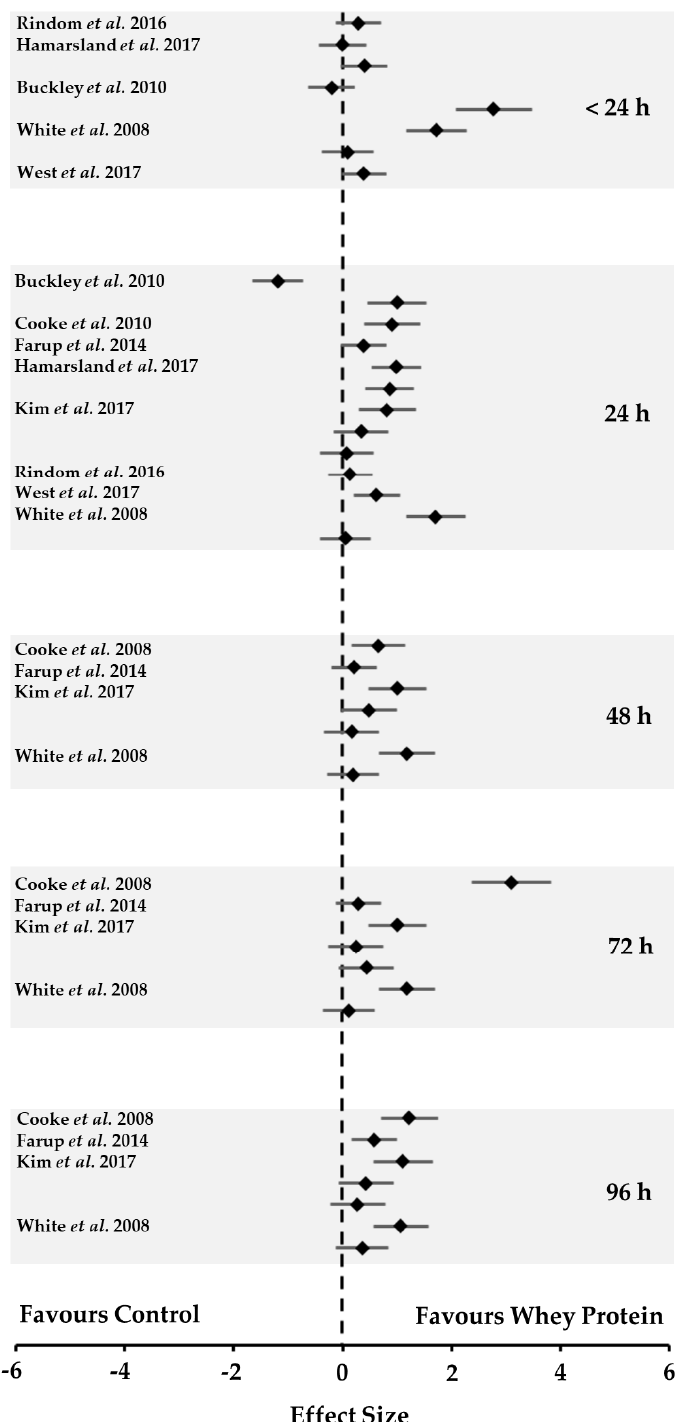
Figure 1. Forest plot of the temporal effect sizes (ESs) of the whey protein supplement for the recovery of muscle function following resistance training, compared to a control treatment. Data are mean ± 95% CI. ESs are ordered by time.